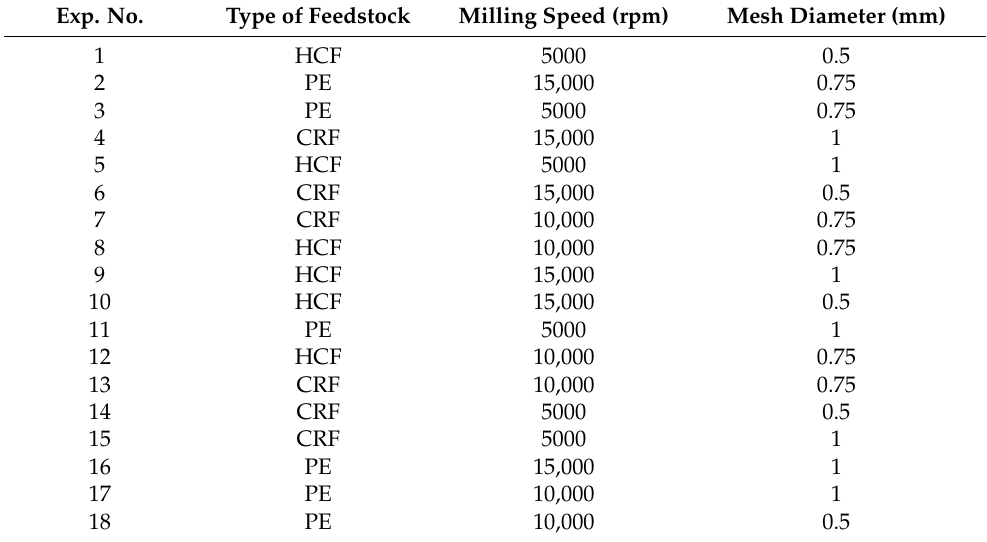
Table 2. Experimental runs as per the experimental design. Exp.